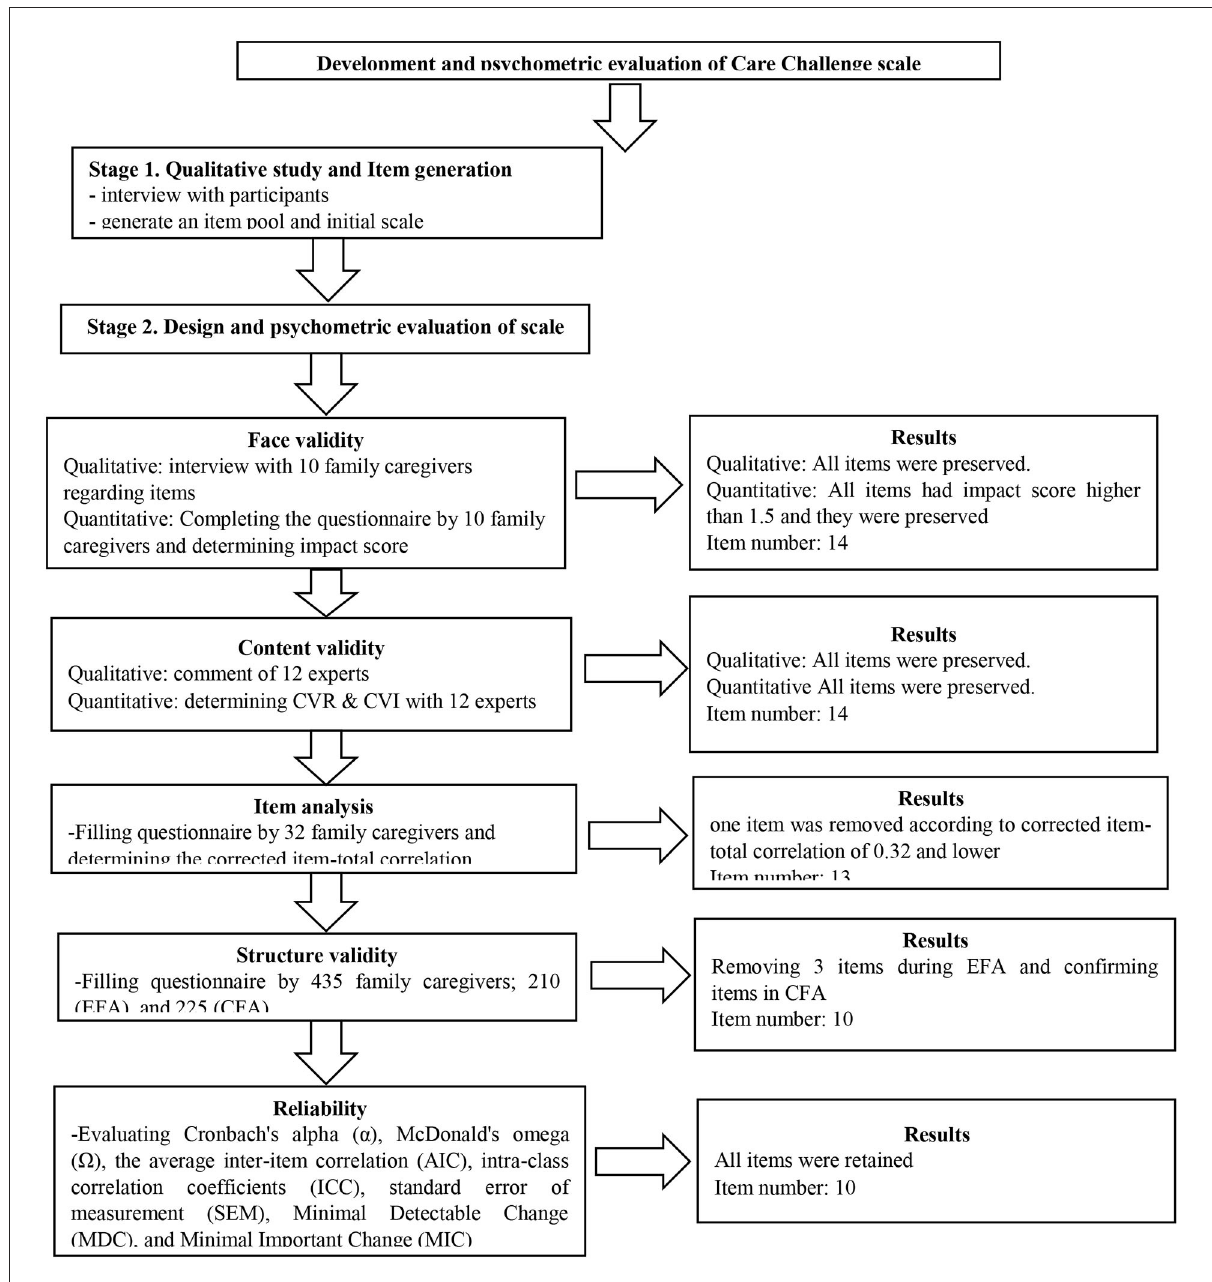
FIGURE1 Production phases of the care challenge